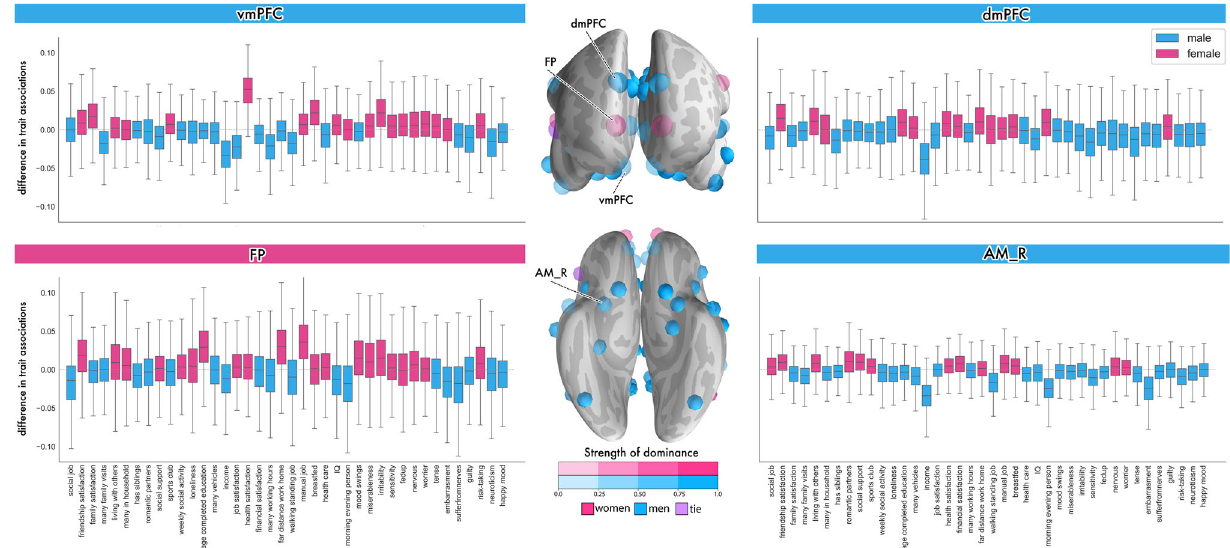
Fig. 5 Degree of sex bias in brain-trait associations in the social brain midline. Left/Right: In each of the 40 examined traits (cf. Supplementary Data 1), boxplots show the difference contrasts between the marginal posterior population distributions of each sex (female – male). Means of posterior parameter distribution above zero indicate a relatively female-biased effect for a speci fi c trait association (pink). For means below zero, there is a relatively male- biased effect for that speci fi c trait (blue). Middle: To provide a summary visualization, we counted across the 40 trait associations, for each brain region, to see how many traits were biased predominantly towards males (blue) or females (pink). Purple shows an equal number of male- and female-biased trait associations. Transparency indicates the strength of the sex divergence. Overall, a male bias in volume effects becomes apparent in almost all examined medial prefrontal and limbic regions. In the dmPFC and AM_R, yearly job income showed a stronger effect in men compared to women. However, women drive the trait associations in the FP of the higher-associative social brain, especially with regards to several demographic traits, such as the age of full-time education completion and working a manual job (cf. Supplementary Fig. 5 for sex differentiation in lifestyle trait associations from the partial correlation analysis; cf. Supplementary Data 2 for a description of the social brain region abbreviations). Error bars/dispersion shows uncertainty of Bayesian posterior parameter distributions. Source data are provided in Supplementary Data